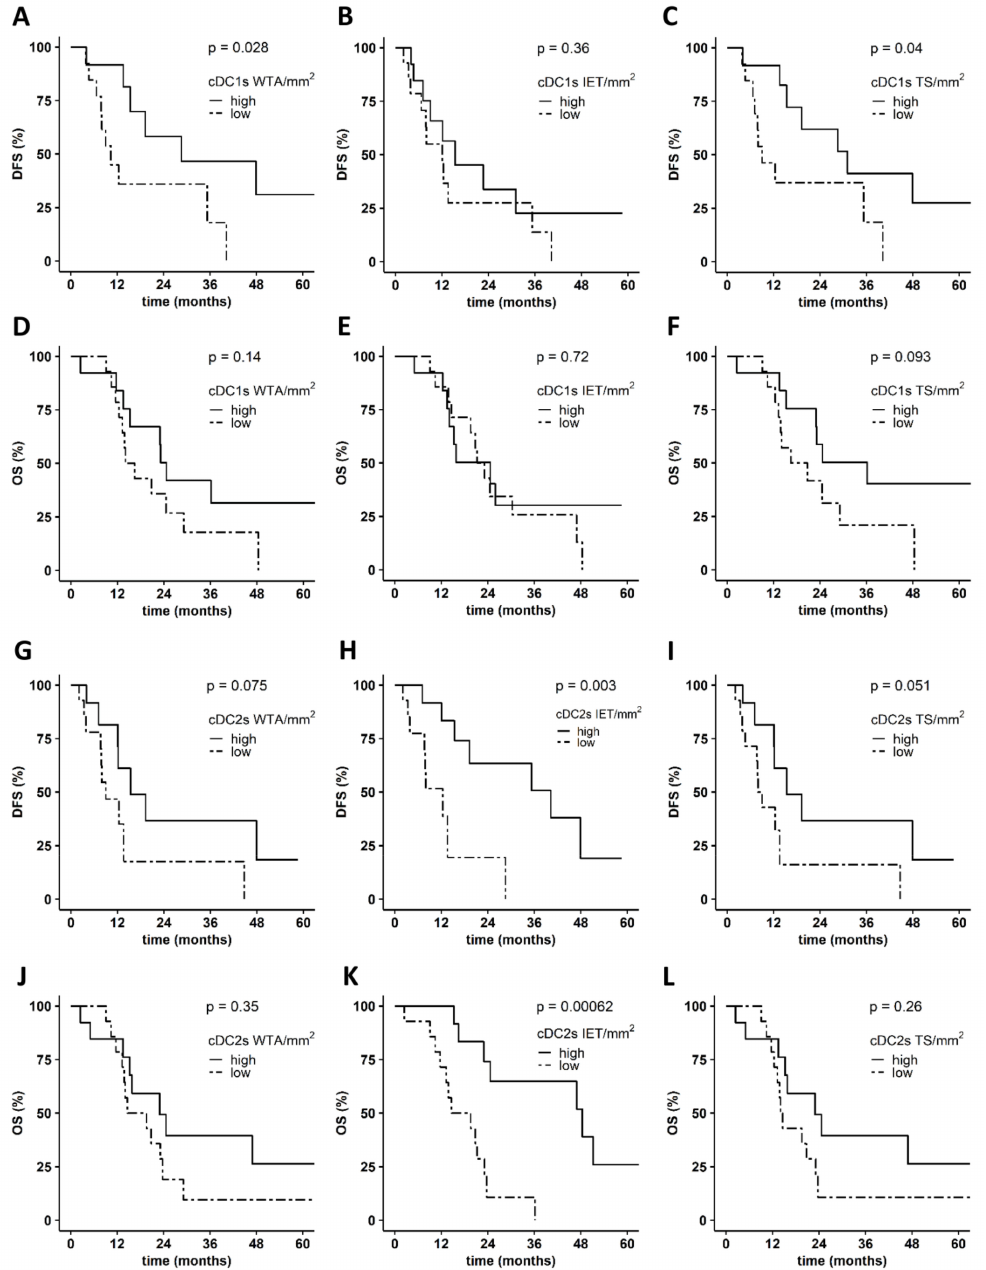
Figure 4. Association between the frequency of pancreatic ductal adenocarcinoma (PDAC)-infiltrating conventional dendritic cells (cDCs) and clinical outcome of patients. Kaplan–Meier curves illustrate the association between whole tumor area (WTA)-, intraepithelial tumor (IET)-, and tumor stroma (TS)-infiltrating cDCs type 1 (cDC1s) ( n = 40) and ( A – C ) disease-free survival (DFS) or ( D – F ) overall survival (OS). Kaplan–Meier curves show the correlation between WTA-, IET-, and TS-infiltrating cDCs type 2 (cDC2s) ( n = 40) and ( G – I ) DFS and ( J – L ) OS. Upper tercile (density>2/3 of the patients in the analyzed cohort; solid line) and lower tercile (density ≤ 1/3 of patients in the analyzed cohort; dash line) were compared. p values were calculated using the log-rank test, and p ≤ 0.05 was considered